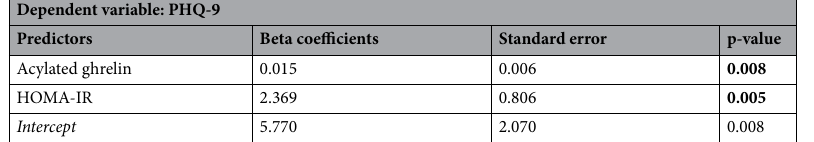
Table 7. Linear regression model for predictors of PHQ-9 among 44 postmenopausal women. R = 0.51, R 2 = 0.26, adjusted R 2 = 0.23, F (2,41) = 7.31, p < 0.002. The model was adjusted for waist/hip ratio (p = 0.109). Bold values indicate statistical significance of p <